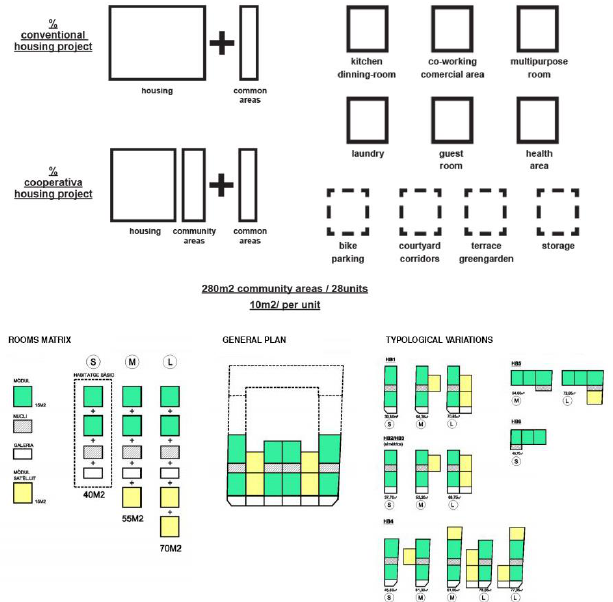
Figure 3. Top: a comparison of the distribution of areas for dwellings and shared spaces in a con- ventional building and La Borda with its additional shared spaces. Below: dwelling layout strategy: green shows the dwelling areas and yellow the “common spaces for private use” (interchangeable rooms between dwellings). While all units are registered as 40 m 2 , the aggregation of yellow rooms allows for different actual dwelling sizes. Source: Courtesy of Lacol.